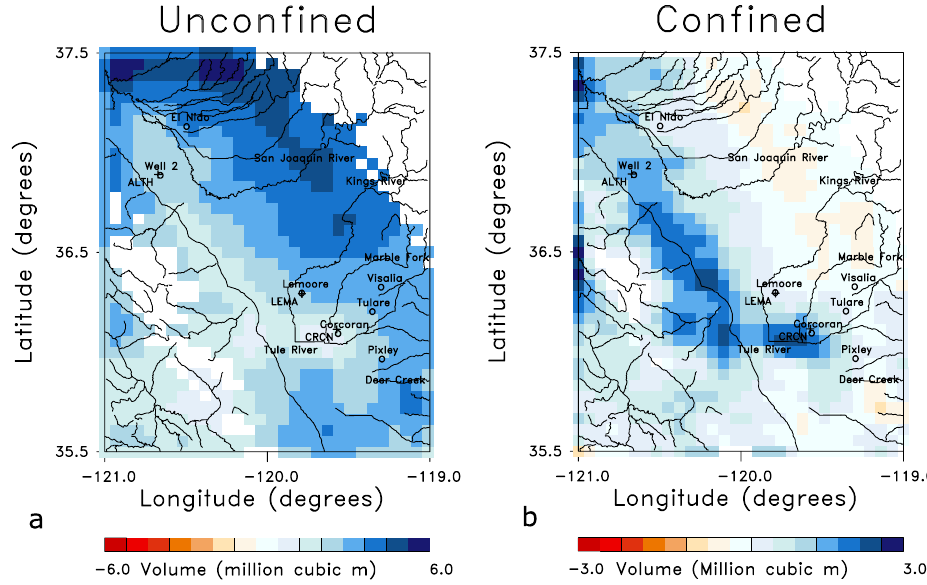
Figure 8. Estimates of the water volume changes in the unconfined ( a ) and confined ( b ) aquifers of the model. The color scale denotes the estimated water volume changes in millions of cubic kilometers during March 2019. Areas with elevations above 600 meters have been removed from the solution because they are likely to be in anomalous mountain areas that do not conform to the model assumptions. The labeling indicates towns, GPS stations, and rivers as denoted in the previous captions. The plots were constructed using NCL and NCAR Graphics 6.5.0 (https:// www. earth syste mgrid. org/ datas et/ ncl. 650.